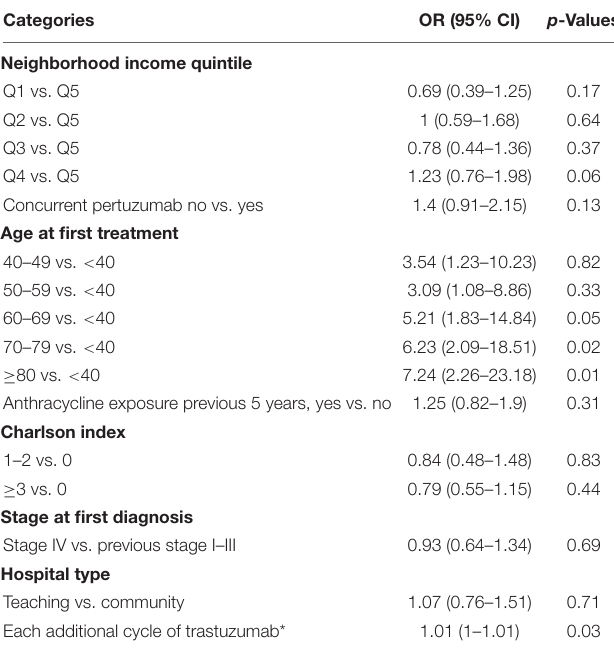
TABLE 2 | Results from logistic regression showing factors associated with incidence of cardiac events in advanced HER2 + breast cancer patients,